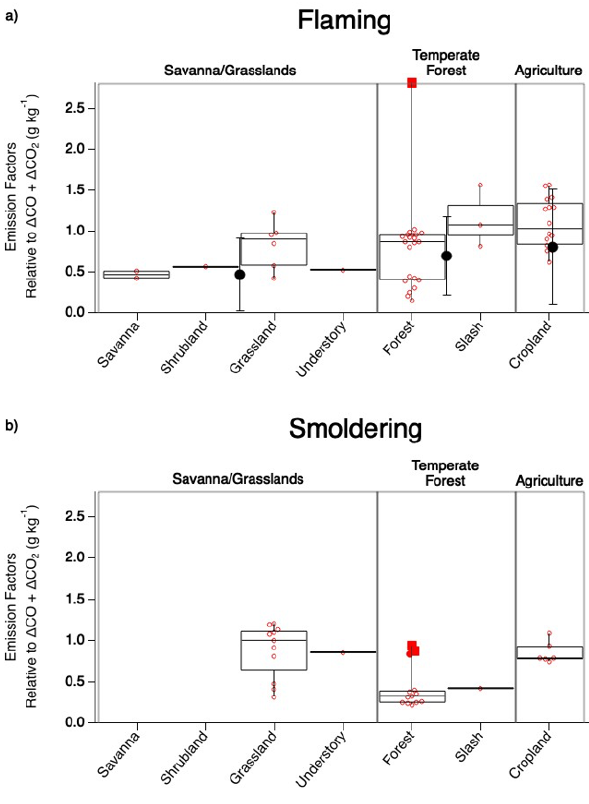
Figure 4. Comparison of SO 2 EF values observed during flaming (a) and smoldering (b) combustion across fuel types sampled during FIREX-AQ. The box upper edge represents the 75th percentile and the lower edge the 25th percentile with the median shown by the middle line. The whiskers represent the minimum and maximum observed values with the open circles representing each observation and the solid red circle representing a potential outlier. The large solid black circles with error bars depicting 1 standard deviation in (a) show corresponding average Andreae (2019)